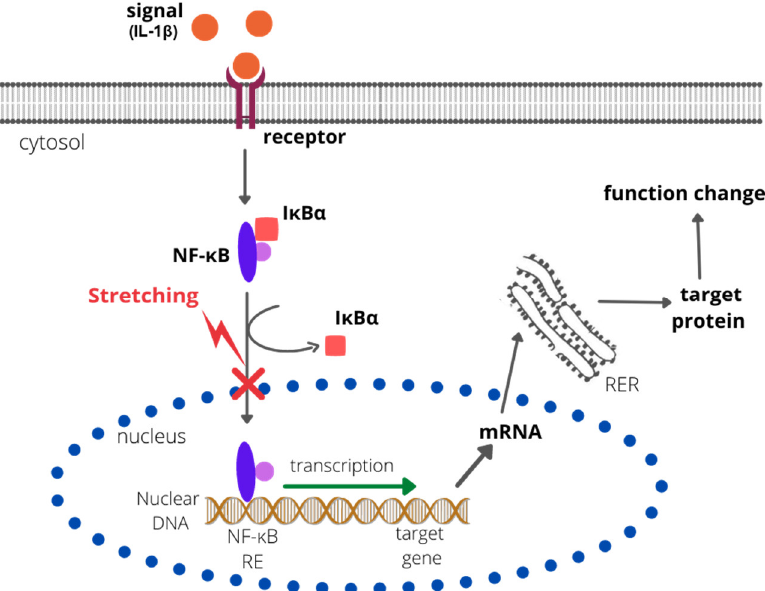
Figure 1. The effect of CTS on the NF-κB pathway. CTS inhibits the degradation of IκBα and IκBβ and rapidly inhibits the IL-1β-induced nuclear translocation of NF-κB. Therefore, the NF-κB response element (NF-κB RE) is not bound by the NF-κB complex, the transcription is not activated, and no target protein is synthesized. RER—rough endoplastic reticulum; IκBα/β—nuclear factor of kappa light polypeptide gene enhancer in B-cell inhibitors alpha/beta).